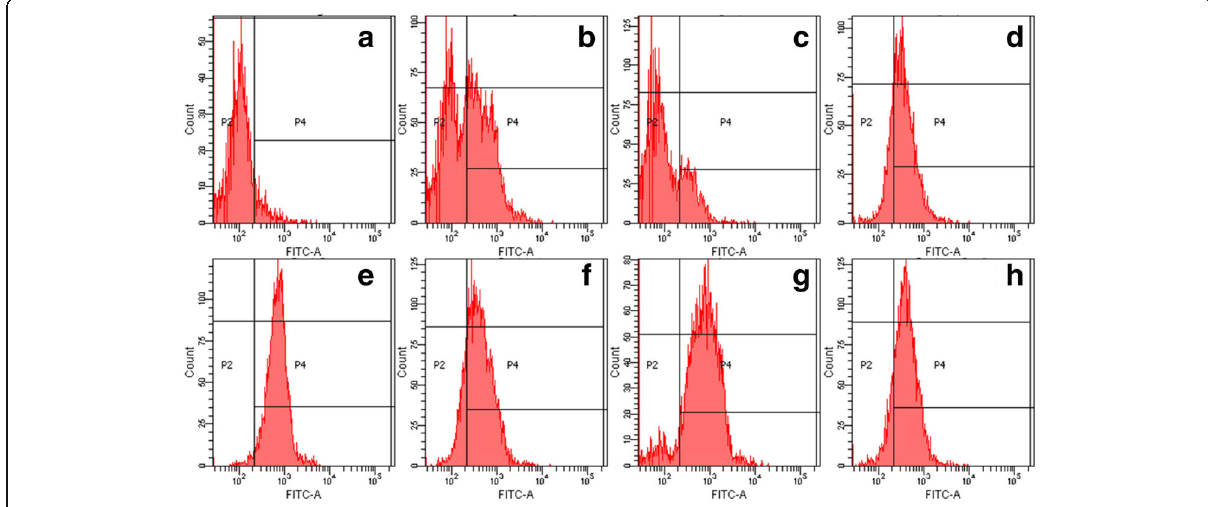
Fig. 4 Cytochrome b558 expressions in neutrophils measured by Flow Cytometry. a the patient. b the patient ’ s sister. c the patient ’ s mother. d the patient ’ s father. e the patient ’ s paternal aunt. f the patient ’ s maternal uncle. g the patient ’ s paternal grandmother. h the patient ’